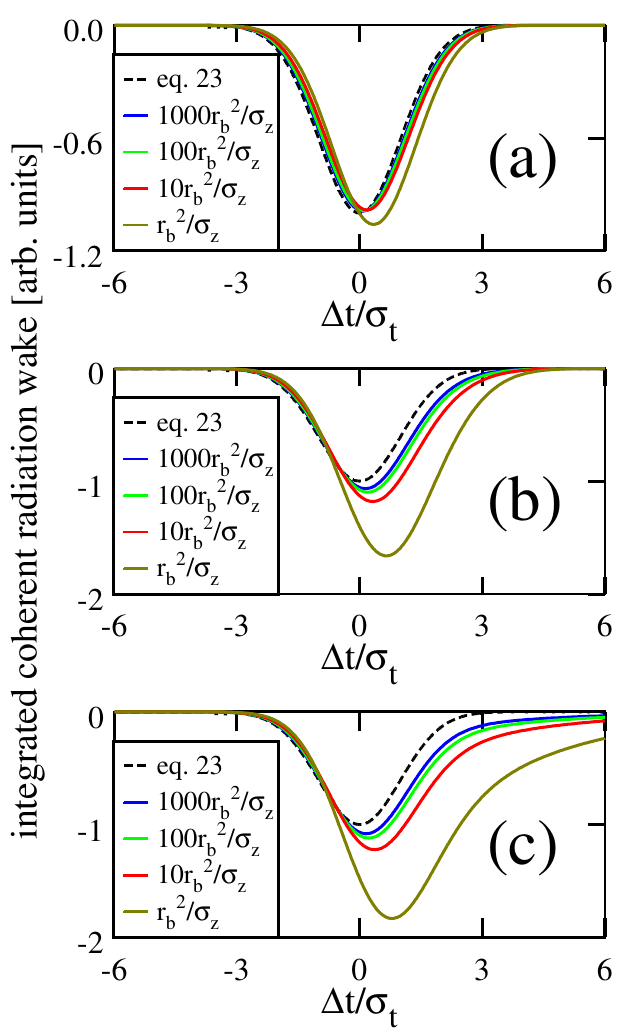
FIG. 2. (Color) For bunches with a Gaussian temporal distribu- tion, the integrated coherent-radiation wake of suddenly accel- erated electrons is computed numerically from Eq. (19) and approximated by Eq. (23). The integrated wakes are computed for four values of the axial coordinate z , and normalized to the height of the approximate integrated wake given by Eq.